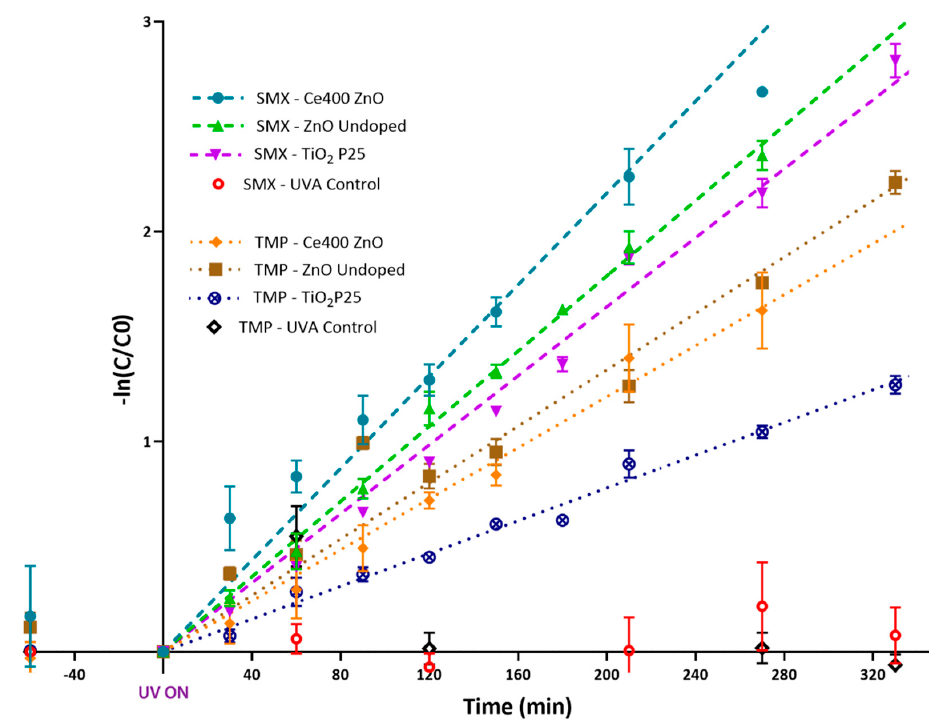
Figure 3. Pseudo first-order plots for the degradation of SMX and TMP with immobilised catalysts. Table 1. Linear regression equations of Figure 3.